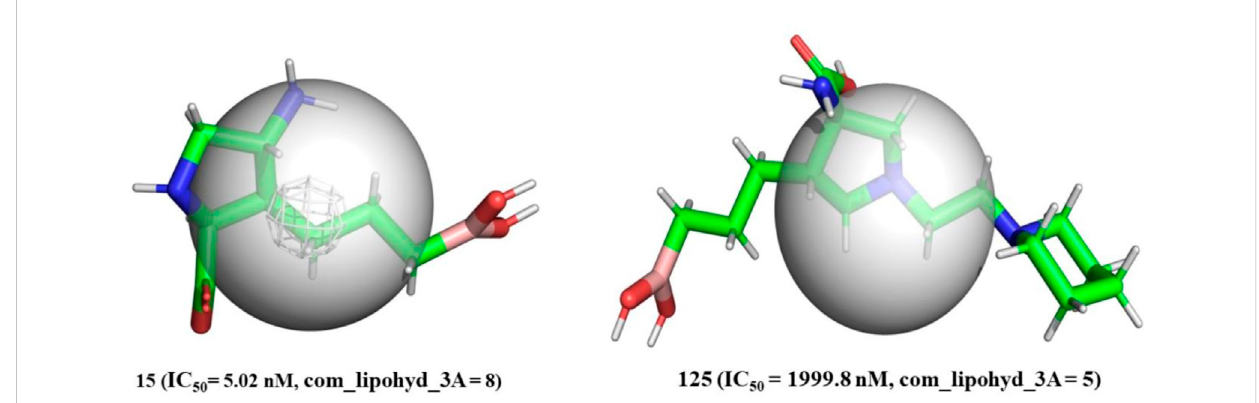
FIGURE 5 Depictionofcom_Hhyd_3Ausingmolecule15(IC 50 =5.02 nM,com_lipohyd_3A=8)andmolecule125(IC 50 =1999.8 nM,com_lipohyd_3A=5)as representative examples only (Radius of gray sphere is 3 Å).